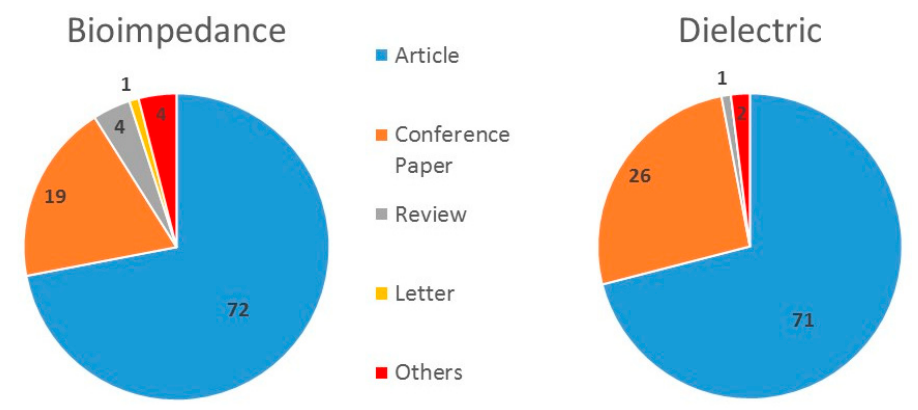
Figure 1. Chart presentation of document type distribution (%): Bioimpedance (1893–2016) and Dielectric (1966–2016).